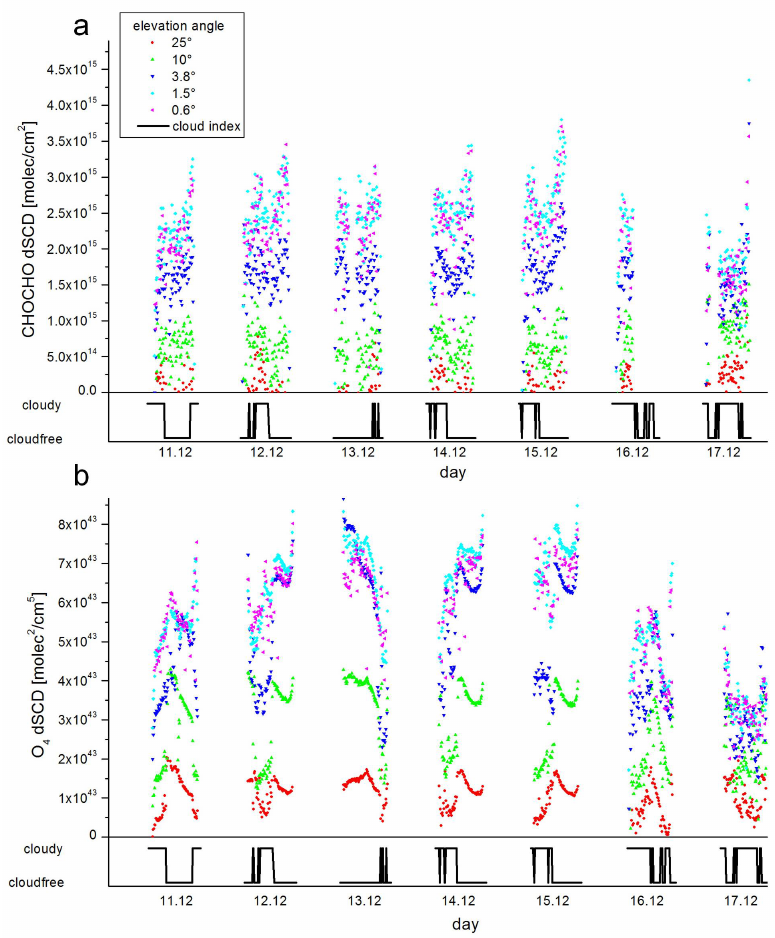
Fig. 2. (a) One week of the retrieved CHOCHO dSCDs from 11 through 17 December 2008. The elevation angles (color coded) are well separated except for the lowest elevation angles and on 17 December. A two level cloud index is added whereby the high value means cloudy conditions and the low value no clouds. (b) The same as (a) for O 4